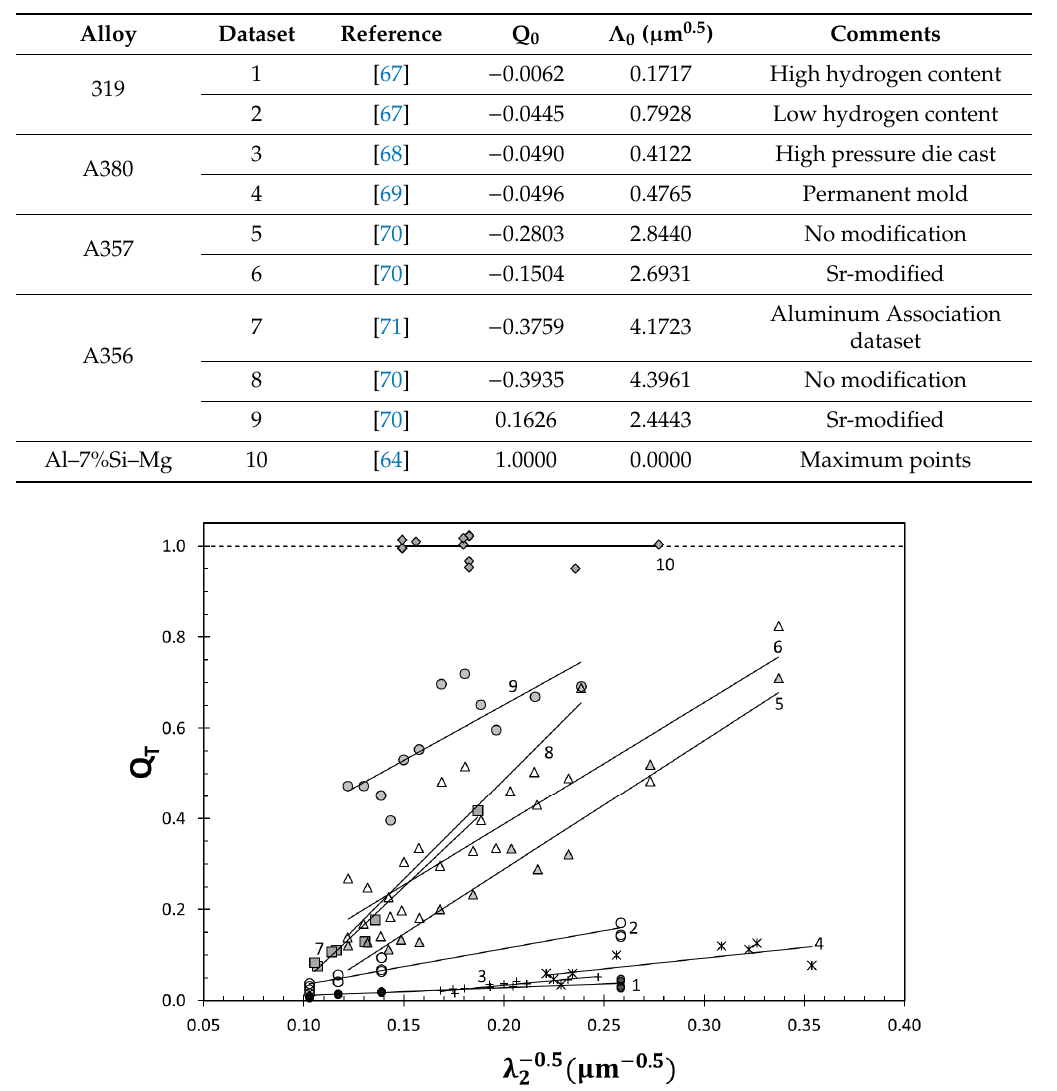
Figure 2. Data from ten independent studies plotted with the inverse of square root of secondary dendrite arm spacing versus the quality index, Q T .